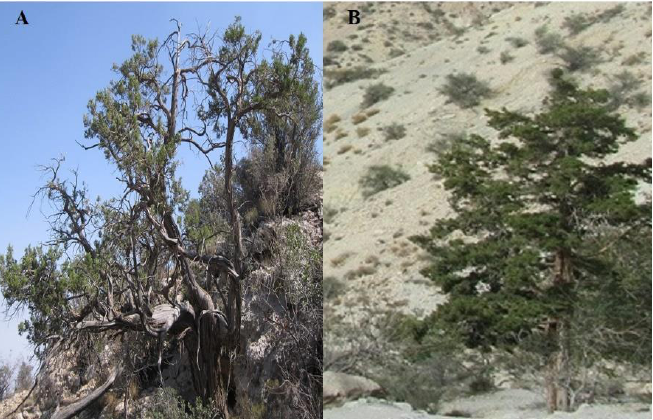
Figure 2. Endangered trees in the ecological landscape of Genow; ( A ) tree with dried branches and ( B ) tree without dried branches.